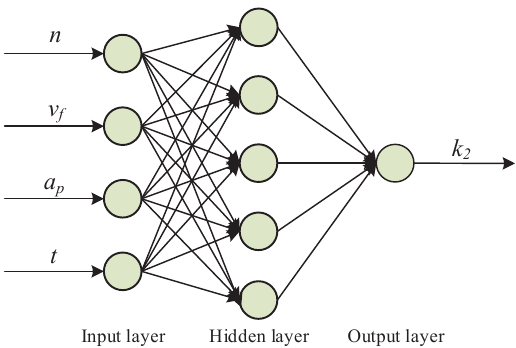
Figure 11. Structure of the implemented backpropagation neural network.